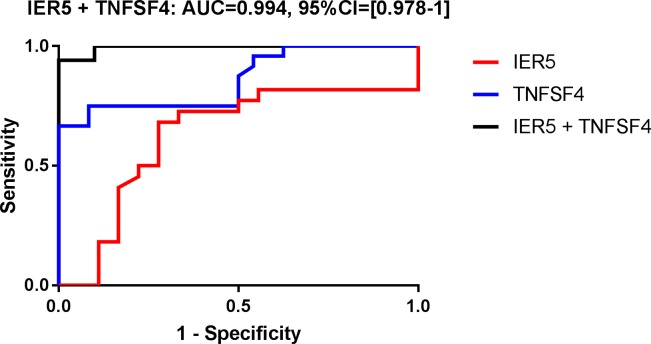
Receiver operating characteristic (ROC) curve analysis of IER5 + TNFSF4 combination that displays area under the ROC curve (AUC) ≥ 0.99 to discriminate radiation dose < 2 Gy from radiation dose ≥ 2 Gy.